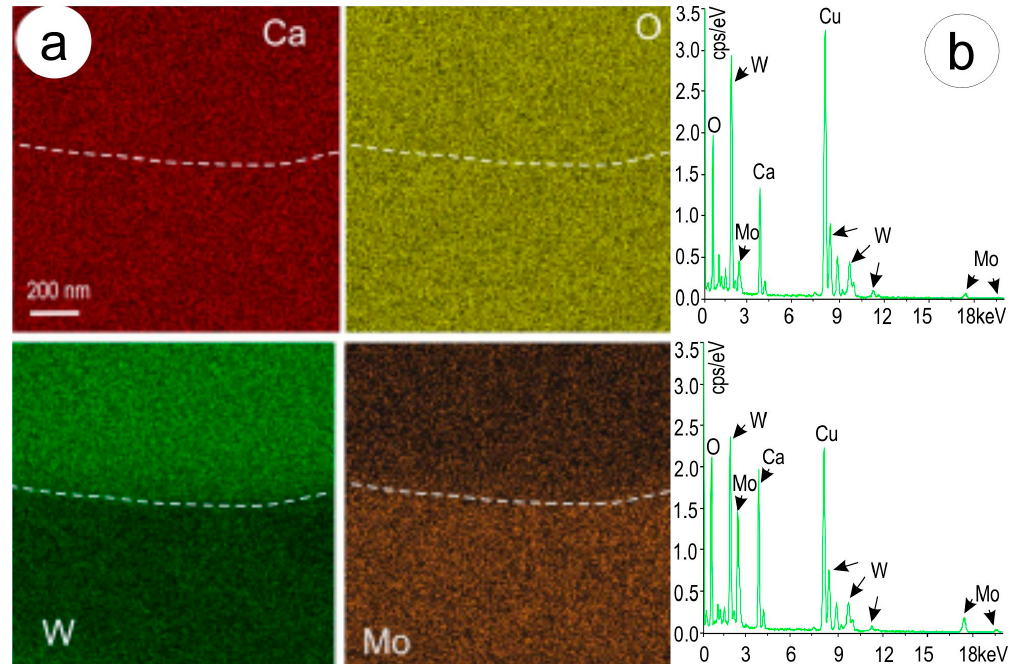
Figure 11. EDS STEM maps ( a ) and spectra ( b ) showing the boundary between the Mo-rich sliver and the matrix. Map location is shown on Figure 10d. The Cu signal is from the TEM grid. High-resolution HAADF STEM imaging of scheelite-powellite on two main zone axes (Figure 12) shows the same patterns for the two domains. The [100] Sch/Pow zone axis (Figure 12a,b) features pairs of bright W and Mo, and less bright Ca, atoms forming dumbbell arrays, whereas on the [1(cid:3364)10] Sch/Pow zone axis, atoms of the same HAADF intensity and size form a tighter rhomb-shaped pattern (Figure 12c,d). STEM simulations show a good fit with the images and the crystal structure models (Figure 12e,f).The latter allow interpretation of the HAADF STEM images in terms of atom types, that is, brighter spots correspond to W or Mo, and the less brighter spots to Ca on the [100] zone axis. An overlap between W, Mo, and Ca atoms accounts for the even intensity of spots on the [1(cid:3364)10] zone axis.